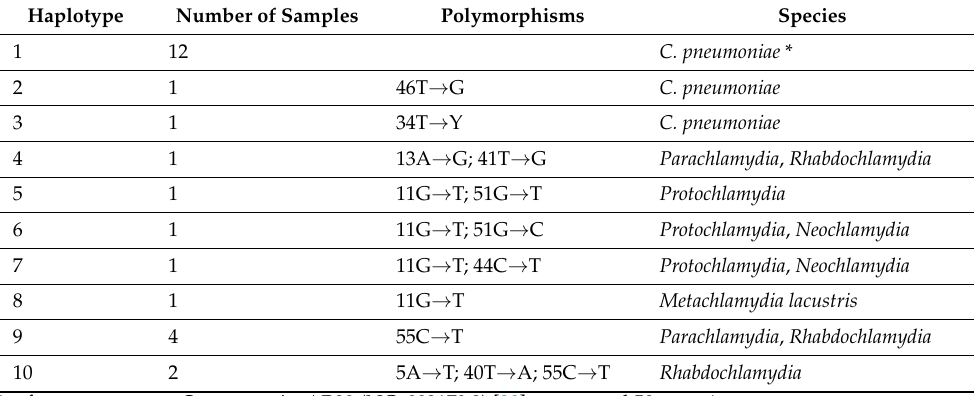
Table 3. Haplotype summary.